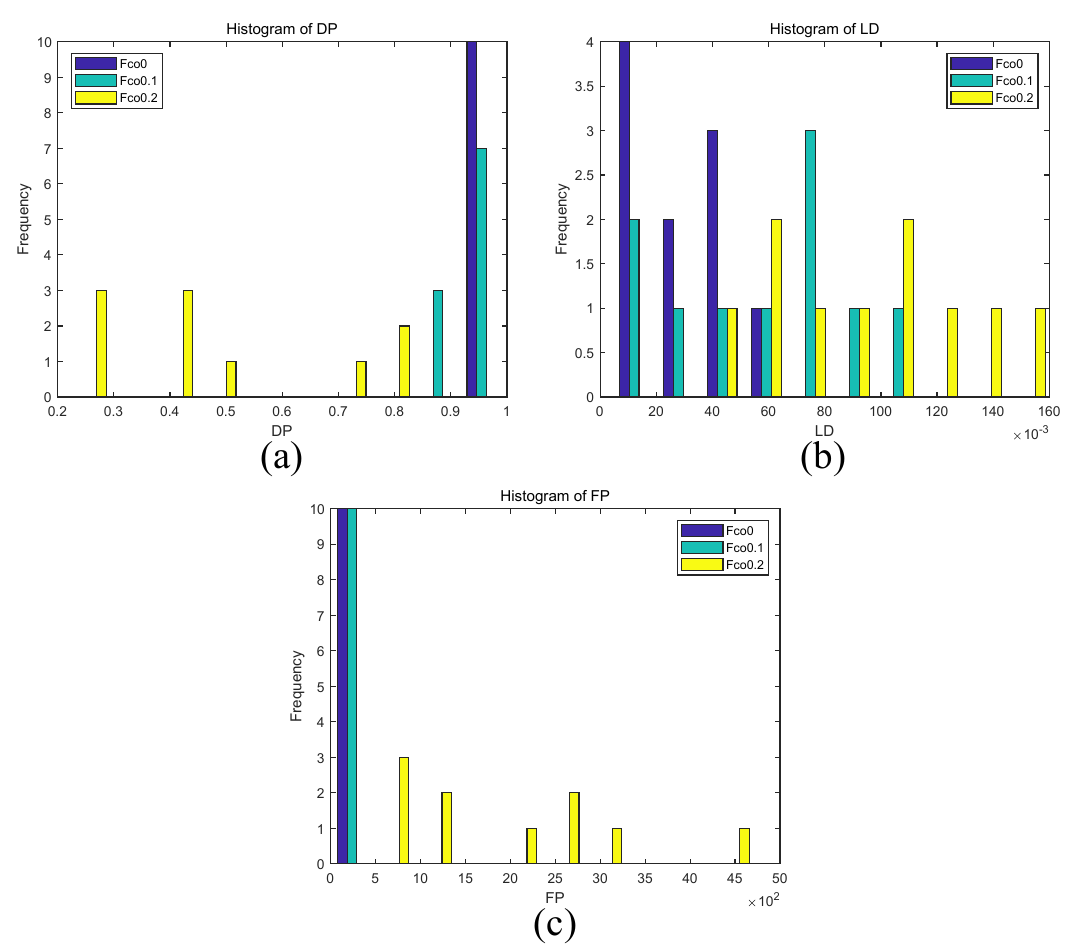
Figure 5. Histogram results of DP , LD and FP of the proposed method with three different cut off frequencies 0, 0.1 and 0.2 Hz: ( a ) DP histogram, ( b ) LD histogram and ( c ) FP histogram.